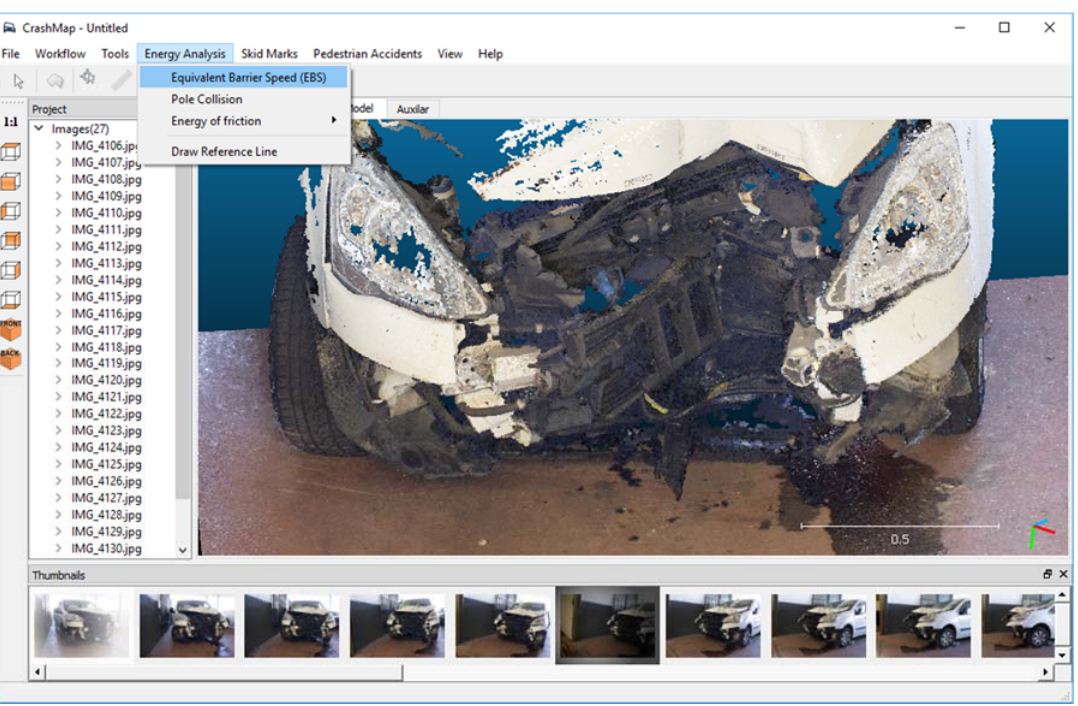
Figure 3. CRASHMAP_desktop interface: tool for the visualisation of photogrammetric 3D models, which can create deformation maps for comparison, dimensional analysis, and energetic analysis.